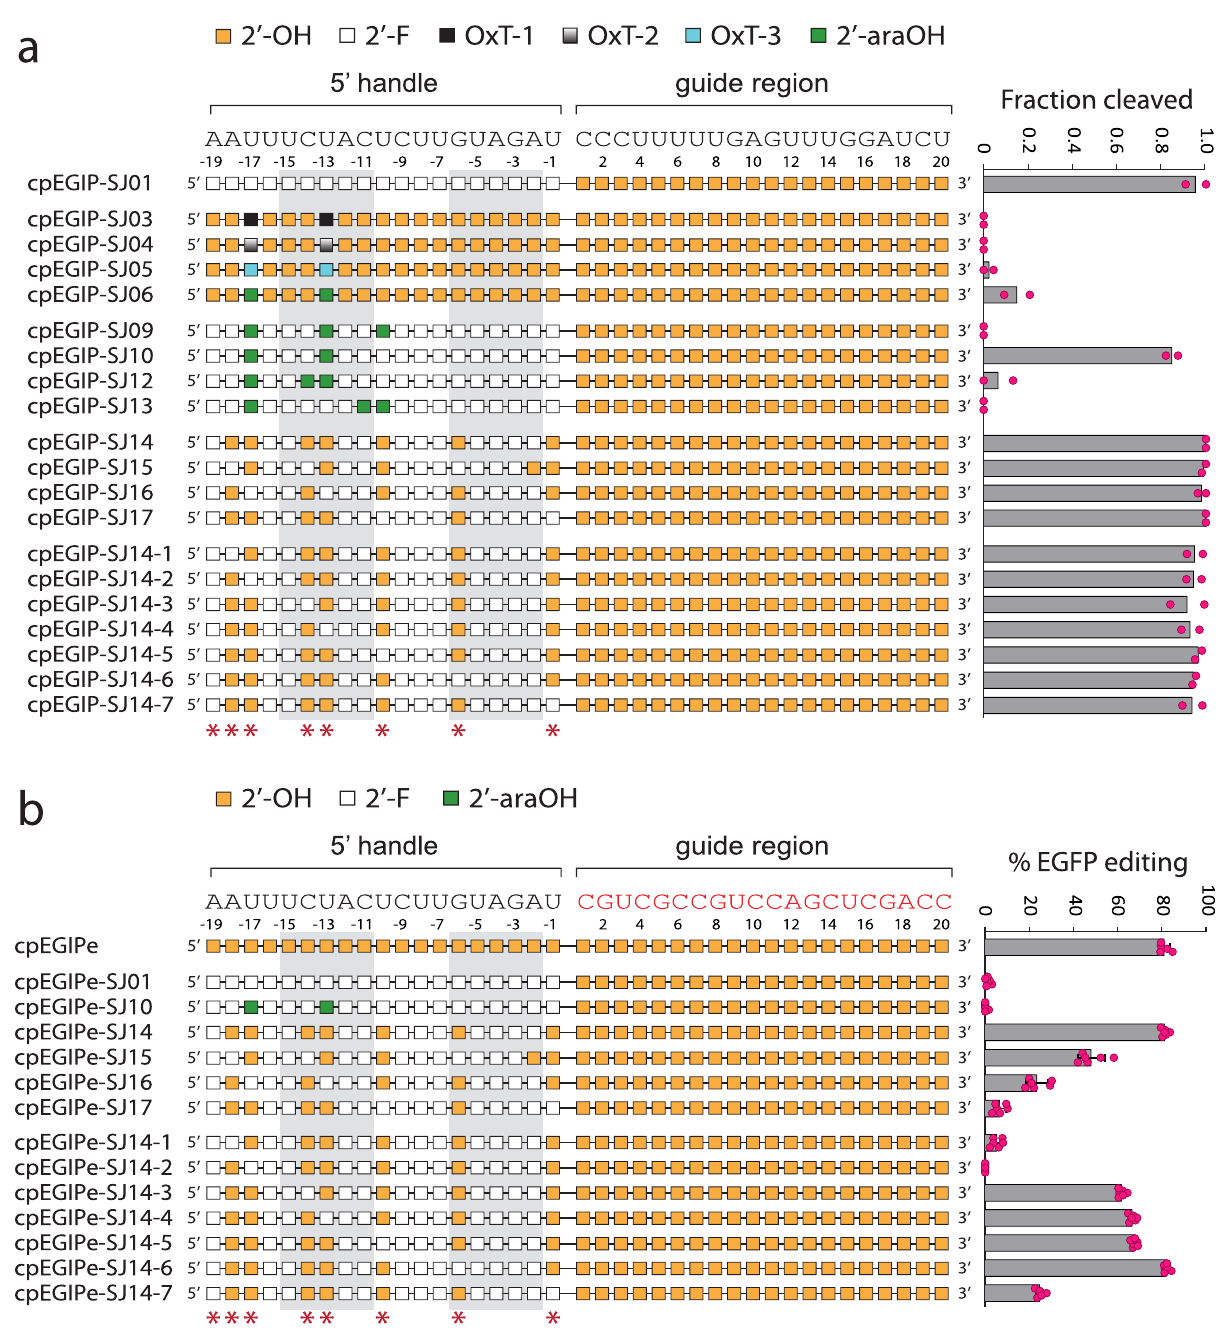
Fig. 3 In vitro cleavage and cell-based editing activity of As Cas12a using crRNA guides modi fi ed with 2 ′ -F, oxepane nucleotides, and 2 ′ -araOH. Chemical modi fi cation patterns are illustrated with corresponding mean in vitro cleavage activity ( n = 2) ( a ) or mean cell-based editing activity ( n = 6) ( b ) shown to the right. Error bars are standard deviation and replicates are biological. For both panels, nucleotides of the 5 ′ handle that are predicted from structural data to make polar contacts through 2 ′ -OH hydrogen bonding are indicated with red asterisks below. The base-paired stem nucleotides of the 5 ′ handle pseudoknot are enclosed with light gray boxes. In vitro cleavage and cell-based editing assays utilize the distinct guide sequences that are shown above each schematic. Source data are provided as a Source Data fi